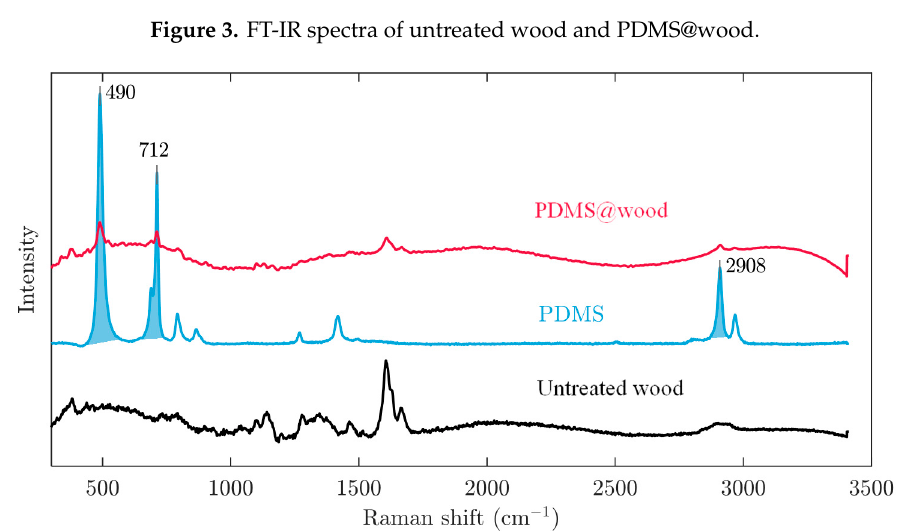
Figure 4. Raman spectra of the untreated wood, PDMS, and PDMS@wood.